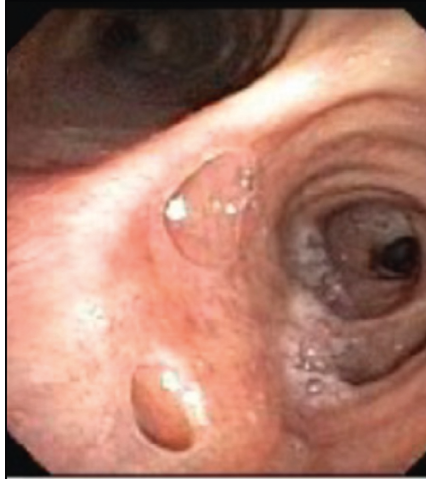
Figure 4: Bronchoscopy. Bronchoesophageal fistulas with open- ings seen in the right mainstem bronchus on the posterior aspect right below the carina at around 6’o clock